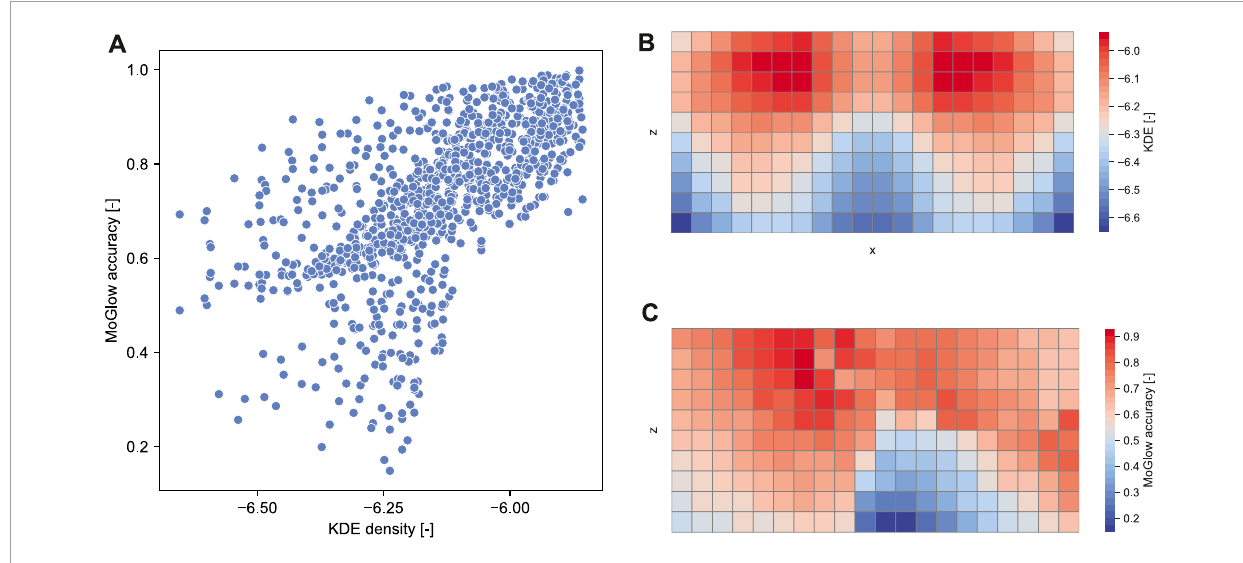
FIGURE 10 Correlation analysis between MoGlow model accuracy and training data density (measured by KDE). (A) Shows moderate correlation between the accuracy and the KDE that corresponds to correlation Spearman-r = 0.718 ( p < 0.001) as presented in Table 2 . (B) and (C) show the KDE grid density and MoGlow accuracy respectively condensed to the x - z axis by averaging over y